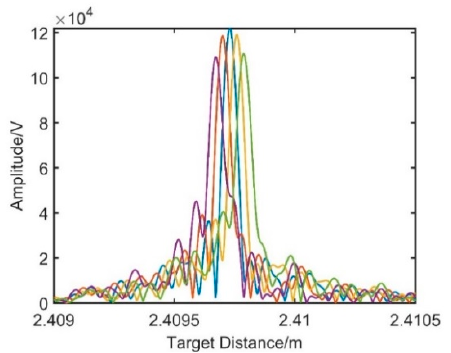
Figure 8. Dispersion compensation under different modulation coefficients.